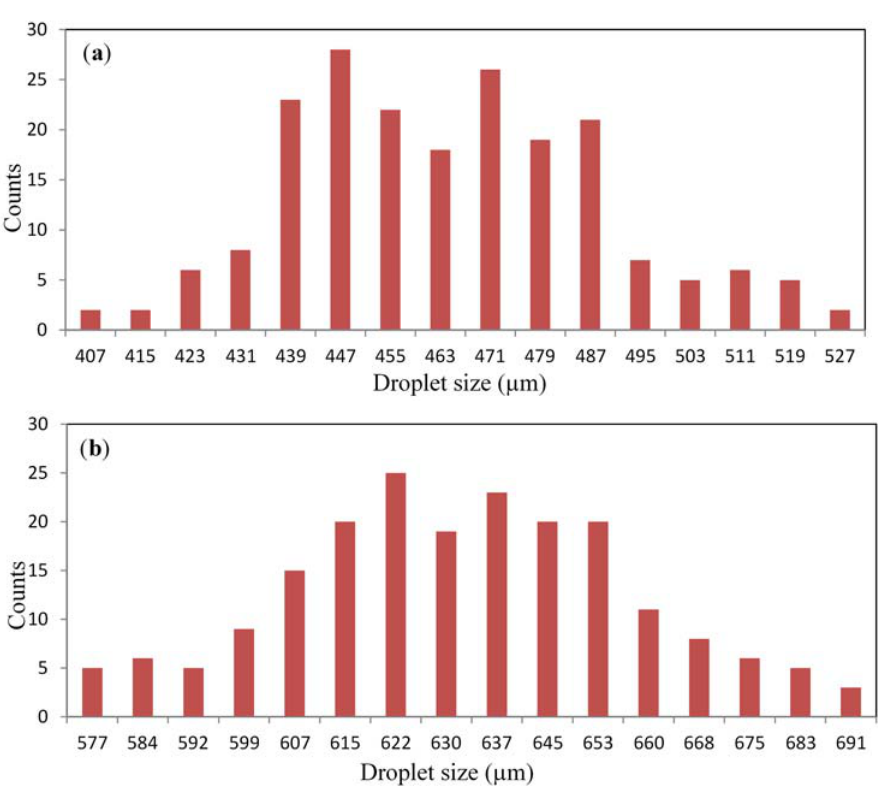
Figure 4. Droplet size distributions of ( a ) 400 µm; ( b ) 600 µm